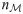
Ensemble predictive skill depending on ensemble size (case study DREAMiS).This curve was computed by bootstrapping multiple nℳ models from the available 100 models, i.e. we sampled multiple realizations of the individual predictions for the same ensemble size and computed the average value. These curves converge asymptotically and show that the chosen ensemble size parameter is adequate. Equivalent predictions could have been obtained with smaller ensemble sizes.